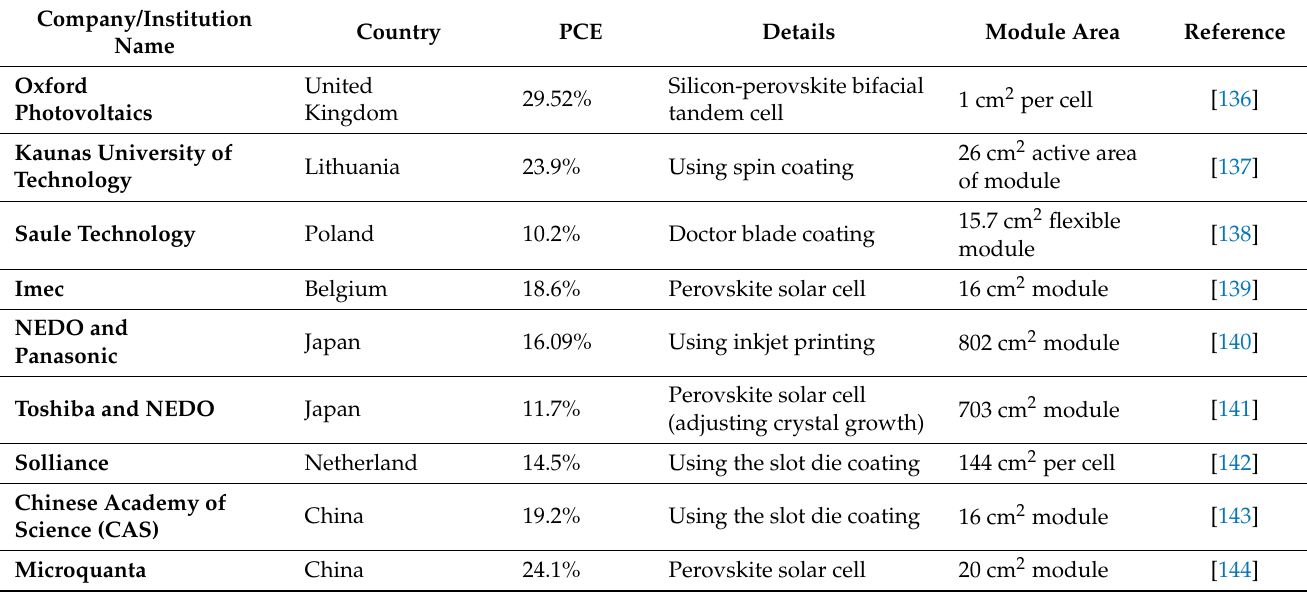
Table 3. Details of large-scale PSC modules fabricated by various companies or